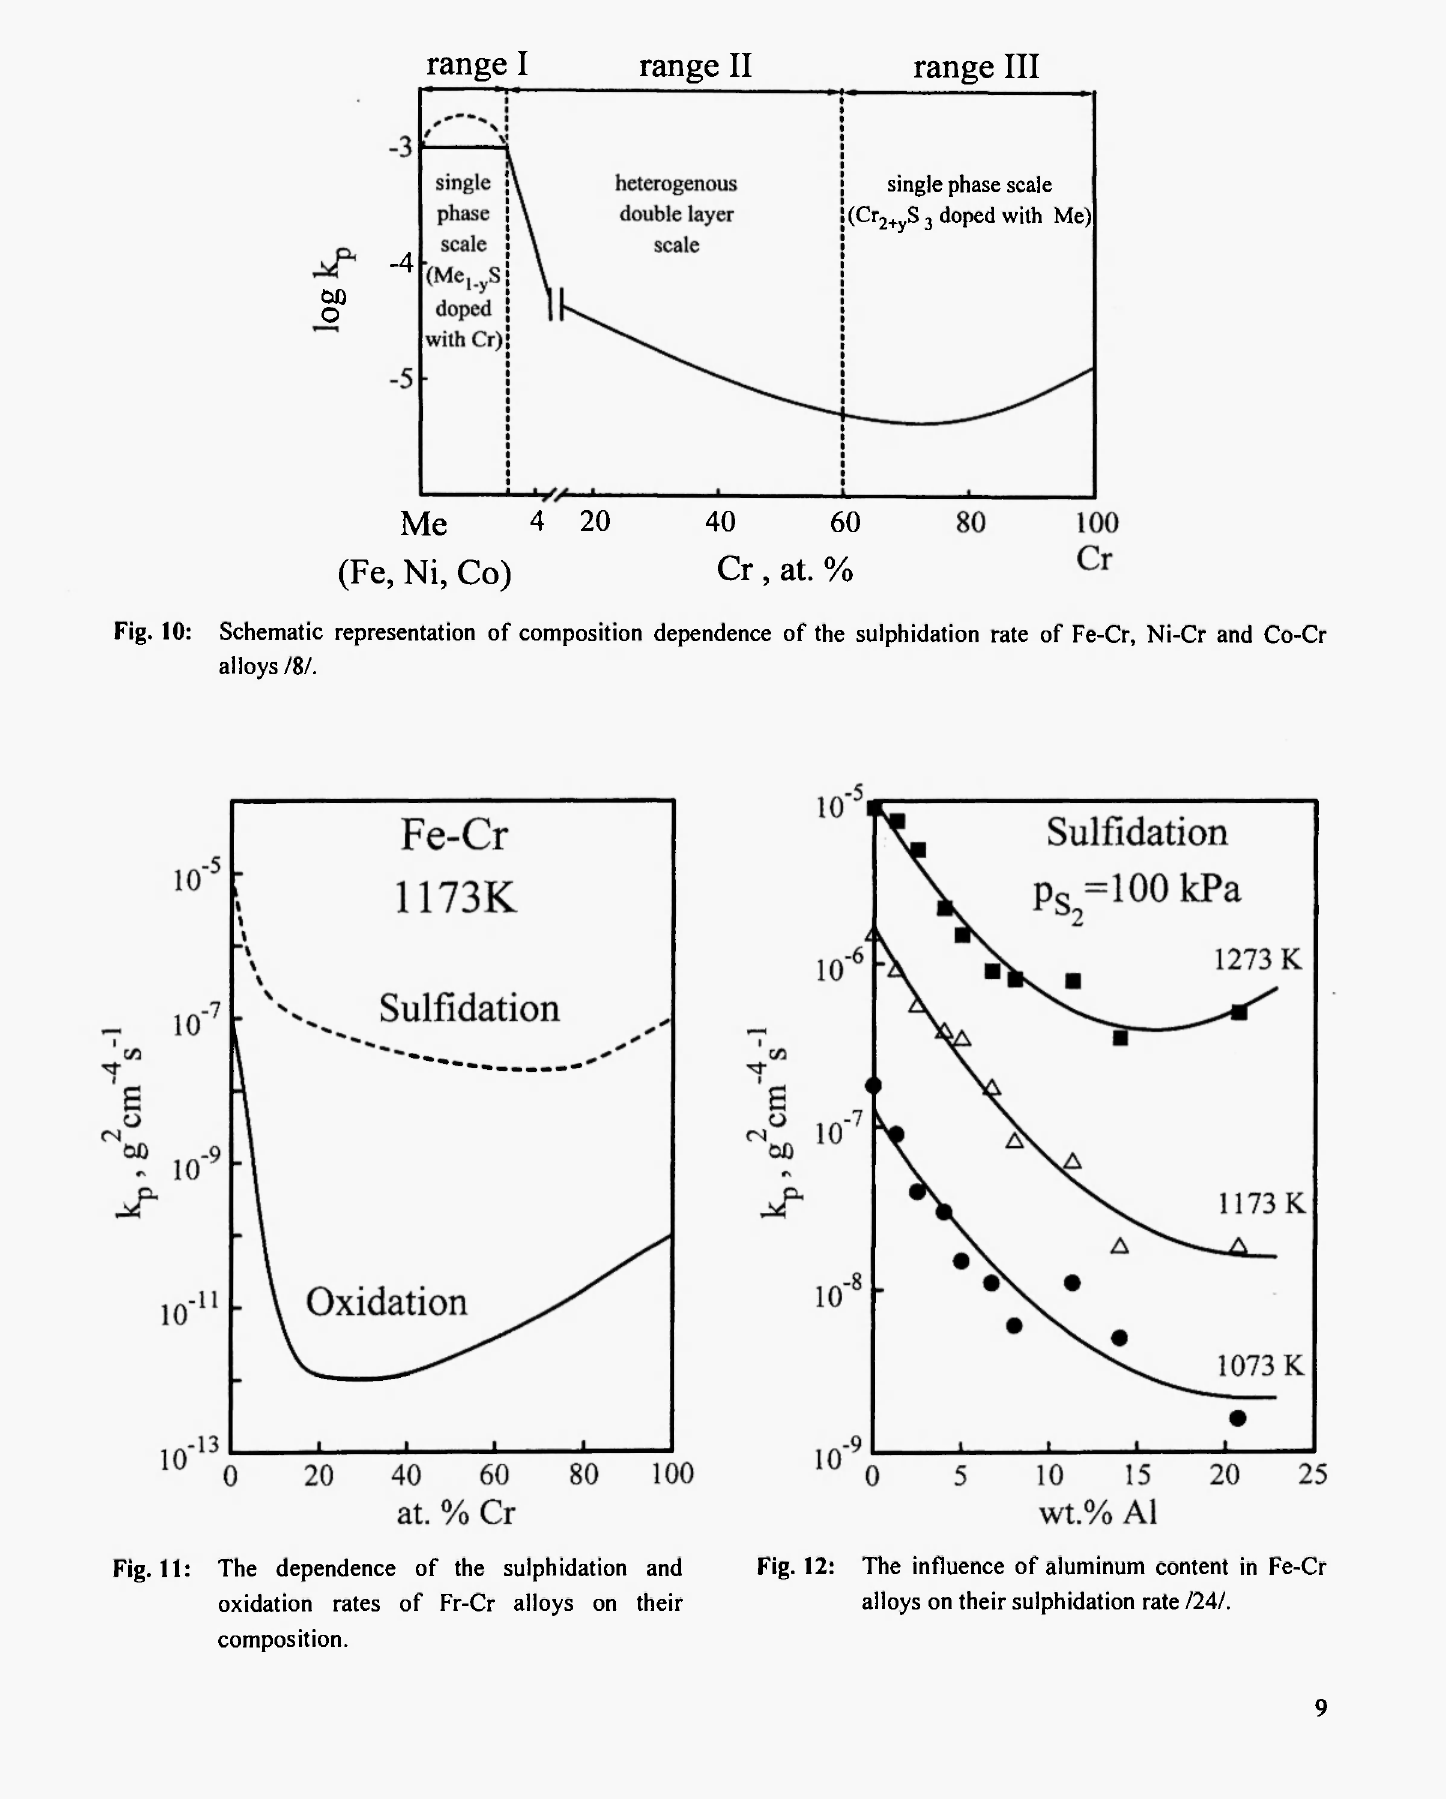
Fig. 11: The dependence of the sulphidation and Fig. 12: The influence of aluminum content in Fe-Cr oxidation rates of Fr-Cr alloys on their alloys on their sulphidation rate/24/.